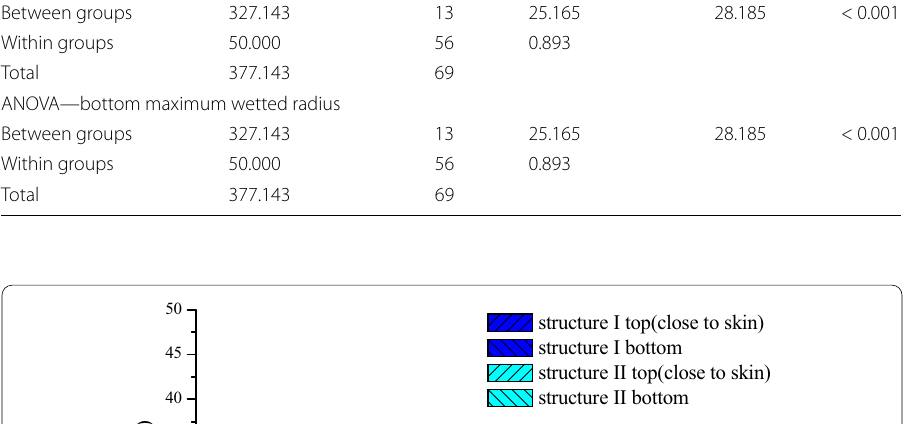
Table 3 The one-way ANOVA test of maximum wetted radius (top and bottom) ANOVA—top maximum wetted radius Sum of squares